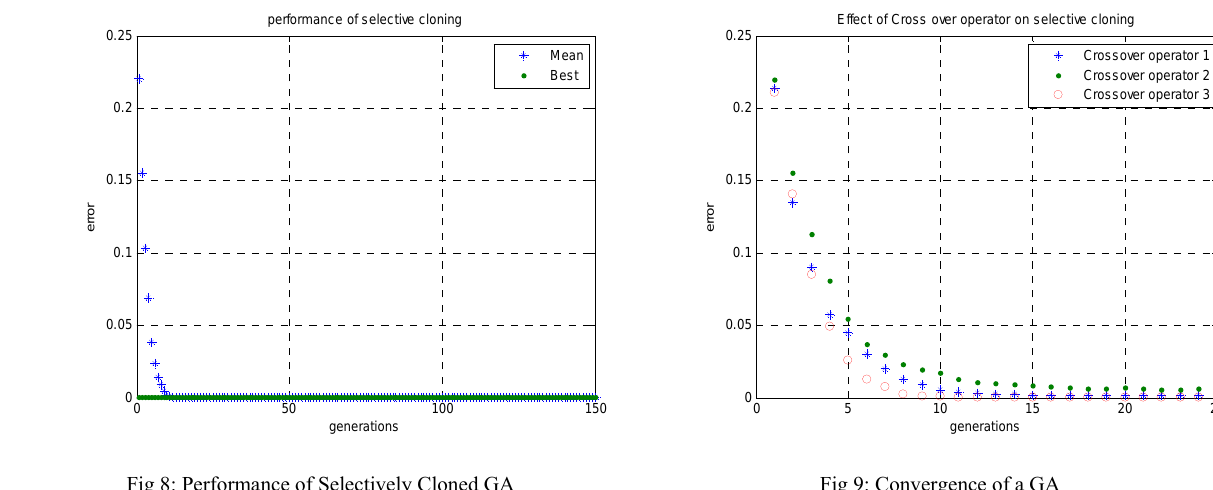
Fig 8: Performance of Selectively Cloned GA Fig 9: Convergence of a